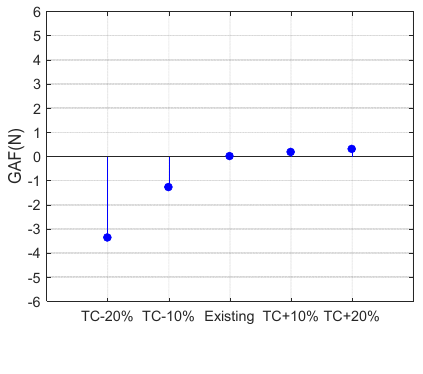
Figure 11. Estimated GAF with respect to design parameters.